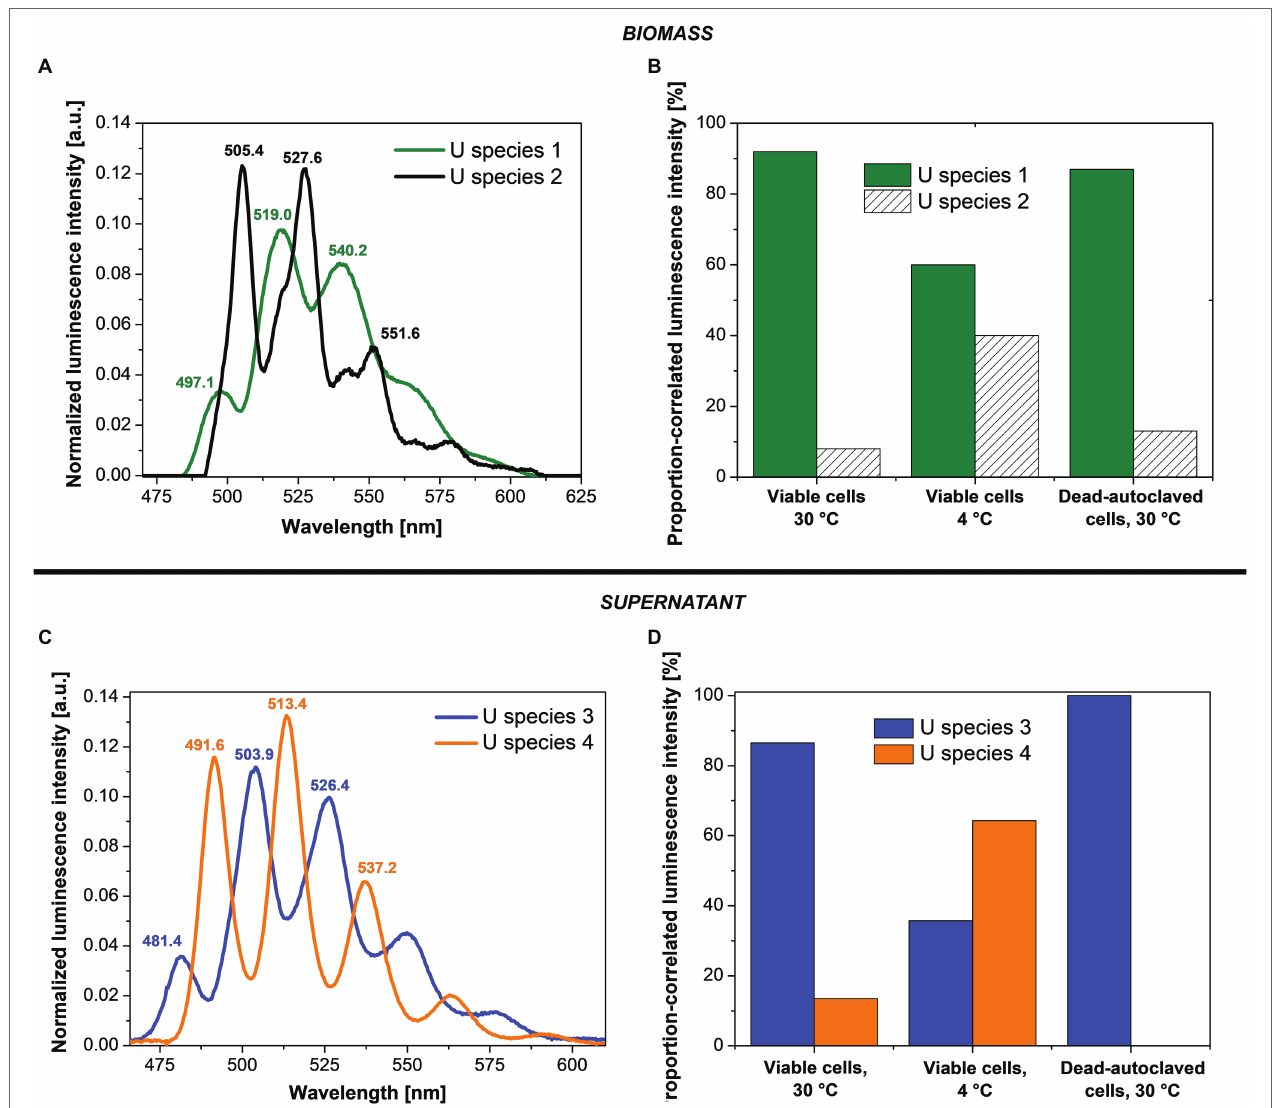
FIGURE 4 | Deconvoluted luminescence spectra (A,C) and species distribution (B,D) based on the PARAFAC analyses of P. simplicissimum KS1 biomass (top) and supernatant (bottom) after 48 h incubation with 0.1 mM U(VI) at pH